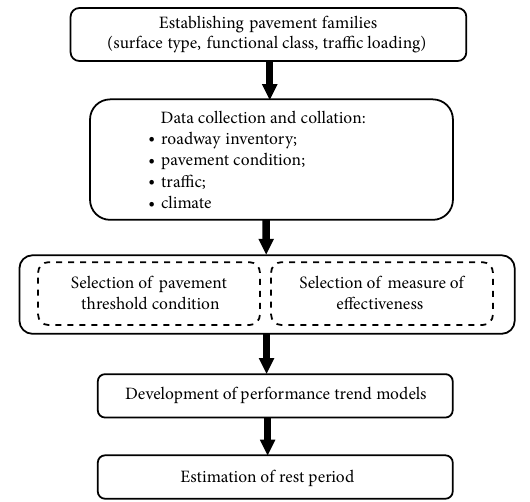
Fig. 2. Generalized framework for estimation